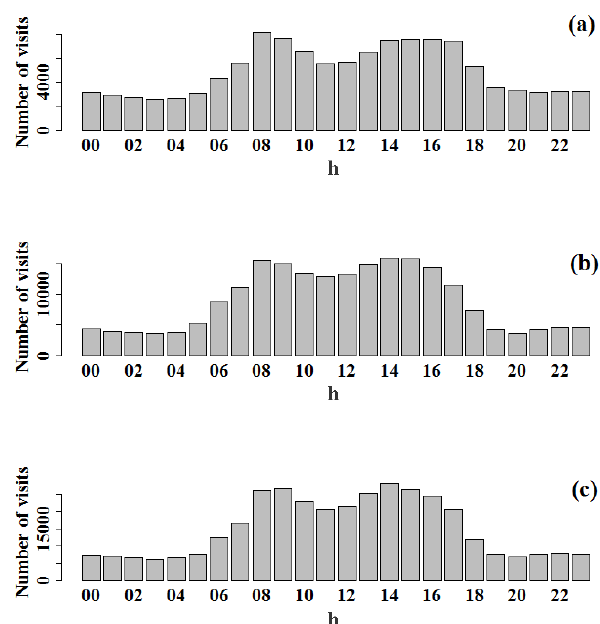
Figure A2. Distribution of the number of visits to FIRE over 24h. Note: the same pattern of two-peaked activity behaviors at the same time was observed across the three breeds. The x axis represents hour, the y axis represents the number of visits to FIRE for the three batches of pigs during the whole test period and (a) , (b) and (c) represent Duroc, Landrace and Yorkshire, respectively.